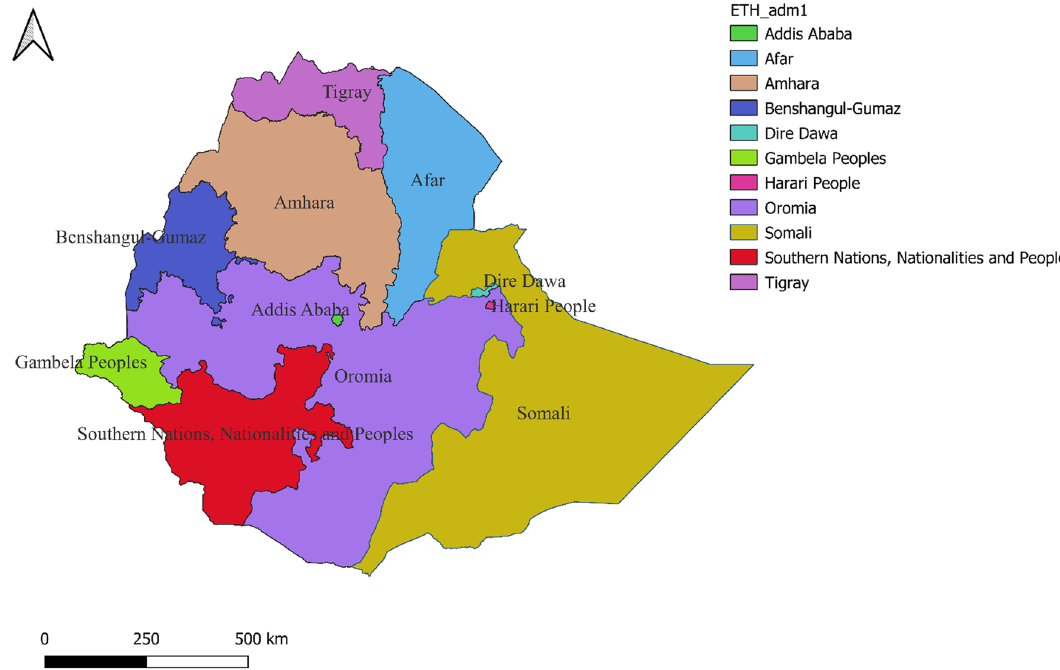
Fig. 2 Map of the study area and the EDHS survey